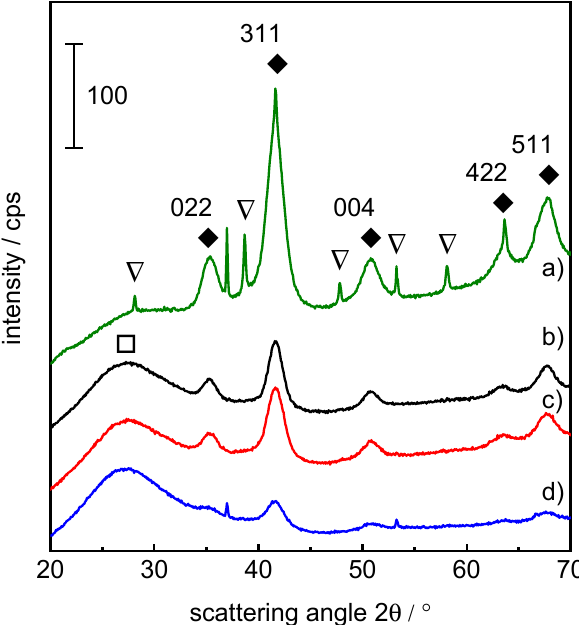
Figure 2. Powder X-ray diffraction (PXRD) patterns with reflexes assigned to γ -Fe 2 O 3 (filled dia- mond), α -Fe 2 O 3 (open triangle), and SiO 2 (open square) of selected as-prepared core–shell catalysts: (a) 42Fe(6)@SiO 2 , (b) 13Fe(8)@SiO 2 , (c) 15Fe(6)@SiO 2 , (d) 15Fe(4)@SiO 2 , (hkl) indices refer to γ -Fe 2 O 3 .